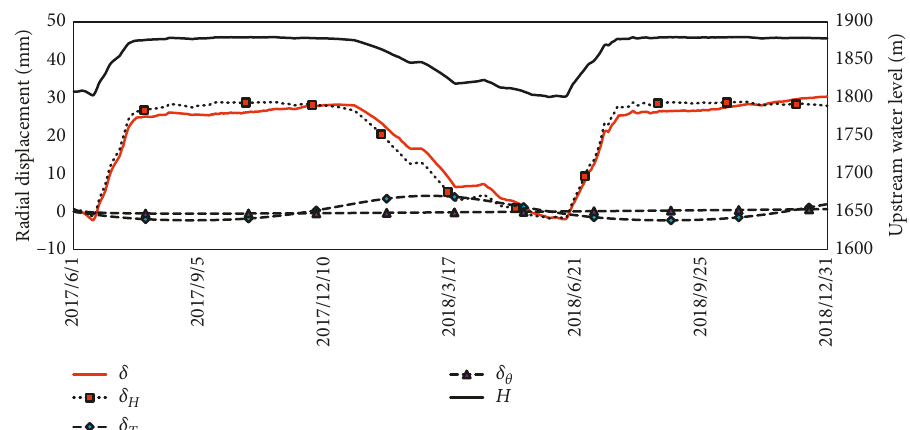
Figure 8: Fitting components of radial displacement of PL13-3. Table 1: Separation results of pendulum radial